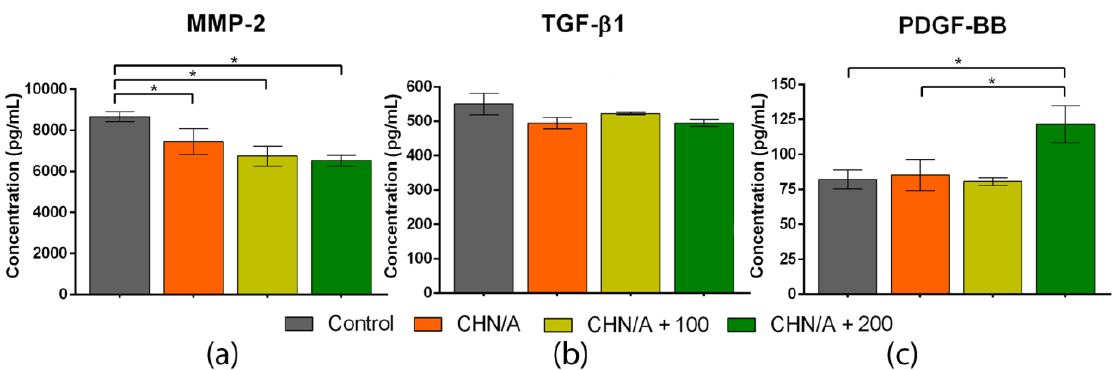
Figure 10. The effect of biomaterials on the production of matrix metalloproteinase-2 (MMP-2) and growth factors by human skin fibroblasts (BJ cell line) cultured for 3 days on the insert membrane assessed by ELISAs: ( a ) Release of the MMP-2 (* statistically significant results between indicated groups, p value < 0.05, one-way ANOVA followed by Tukey’s test); ( b ) Release of transforming growth factor-beta 1 (TGF- β 1); ( c ) Release of platelet-derived growth factor-BB (PDGF-BB) (* statistically significant results between indicated groups, p value < 0.05, one-way ANOVA followed by Tukey’s test).